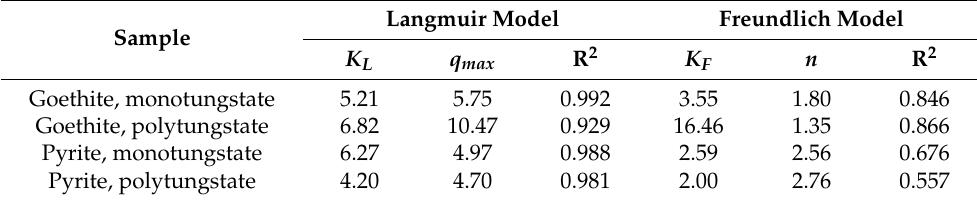
Table 4. Isotherm constants for tungsten sorption onto goethite and